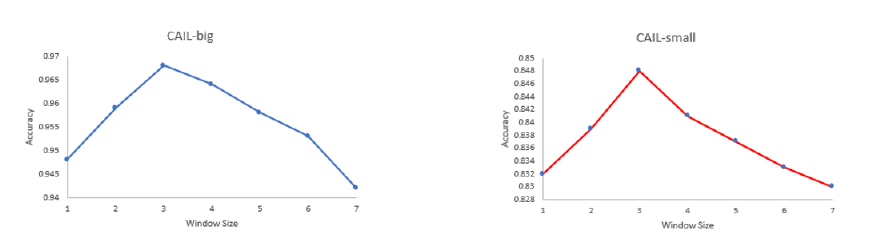
Figure 7. Effect of different window sizes on